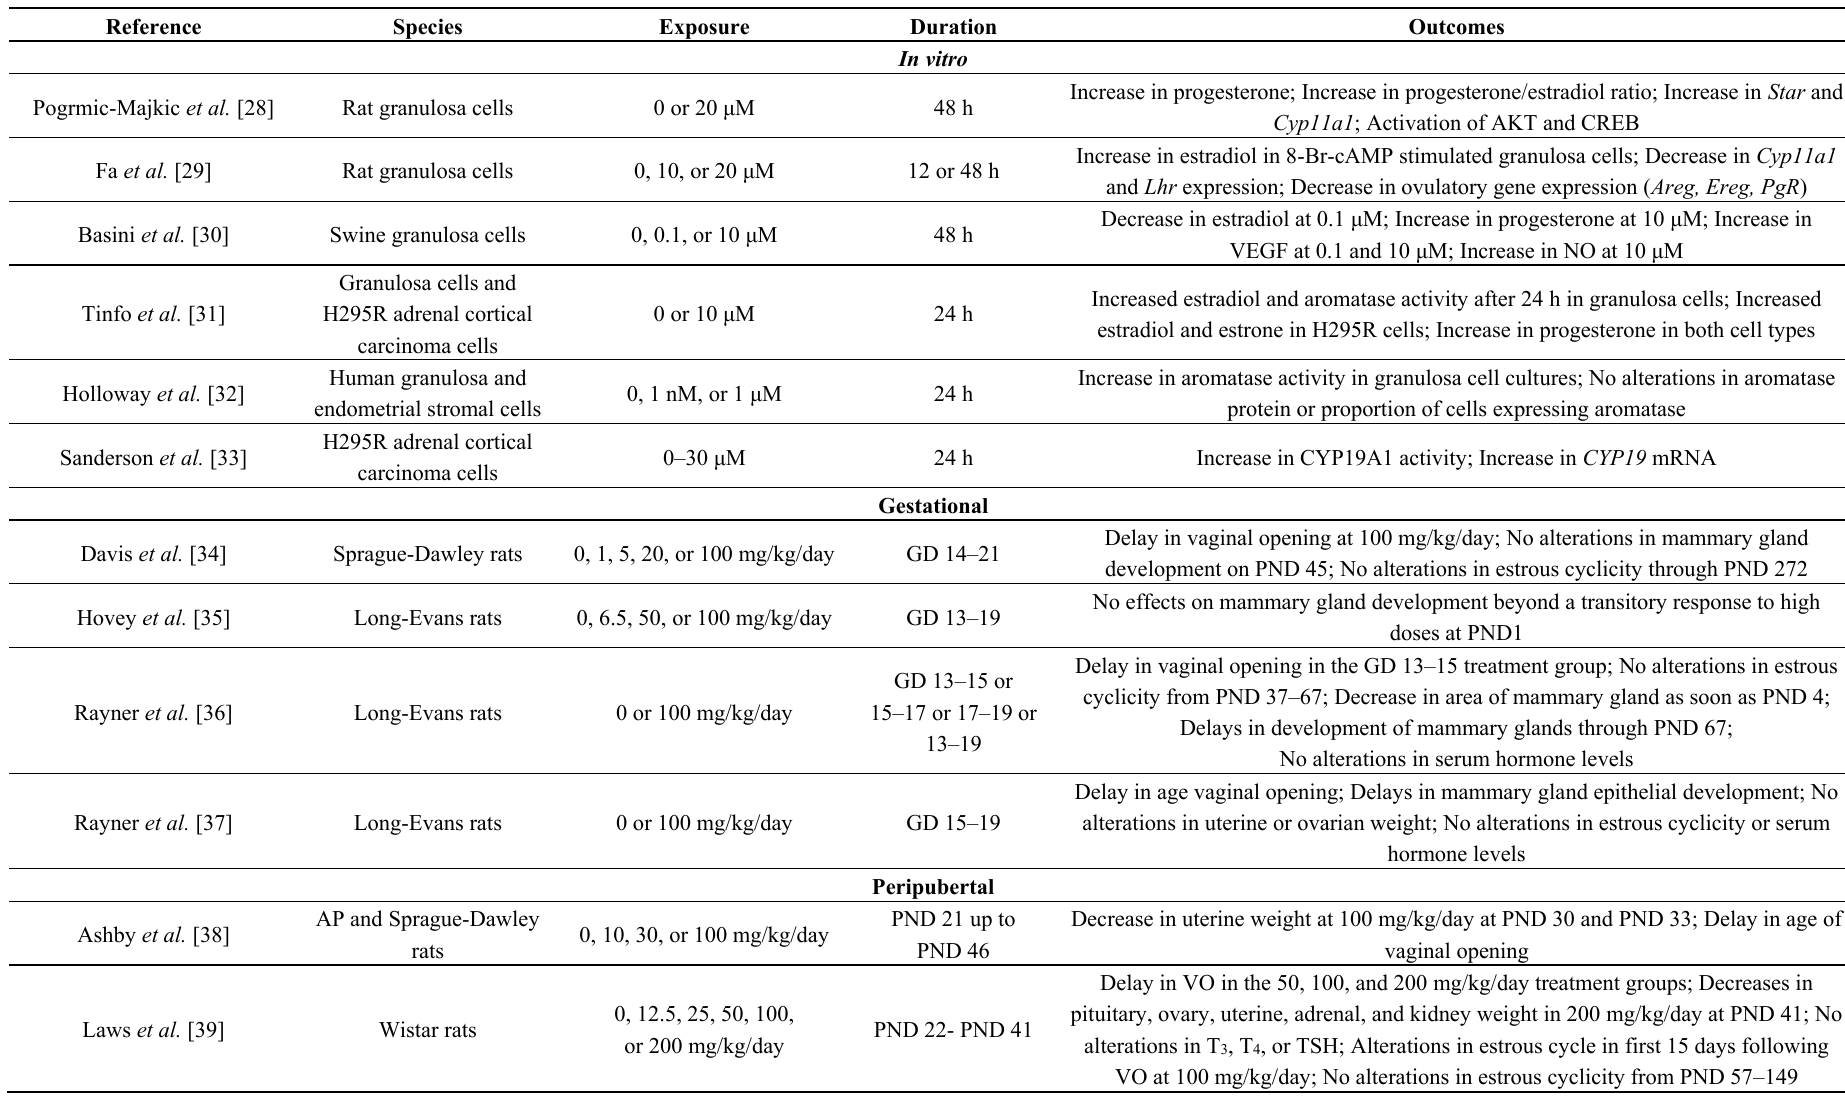
Table 1. Reproductive effects of atrazine in female mammalian